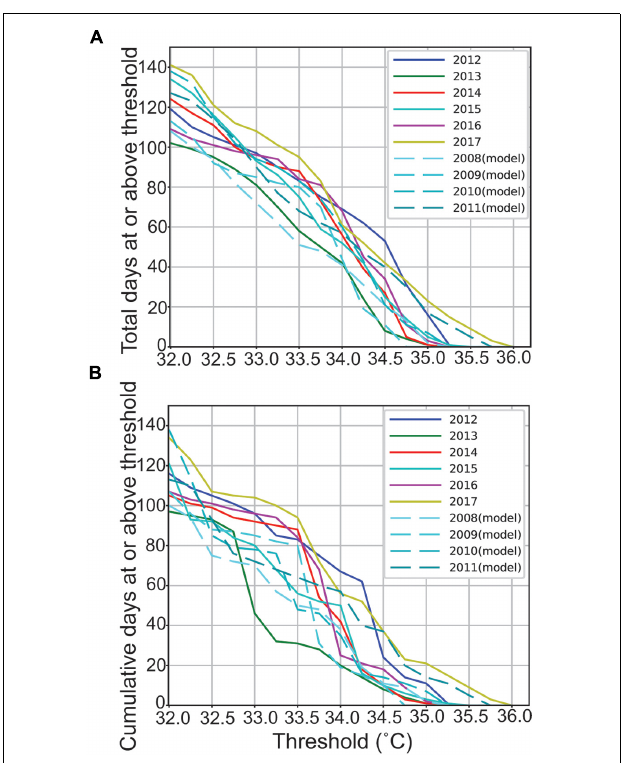
FIGURE 6 | Number of days that corals were exposed to a range of sea-bottom temperatures during summer (July 1 to August 31) for the decade from 2008 to 2017 at Saadiyat reef. (A) Total days over the entire summer, (B) maximum number of cumulative days at or above a given temperature. Both are based on 0.25 ◦ C temperature intervals. The 2008–2011 data are based on bottom temperature simulations from the ERA5 dataset, while 2012–2017 are based on observed bottom